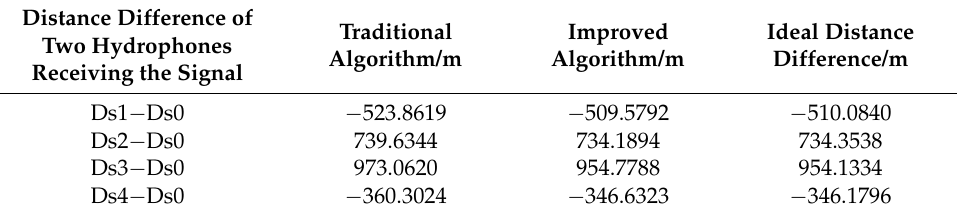
Table 3. Comparison of the calculation results of the distance difference.